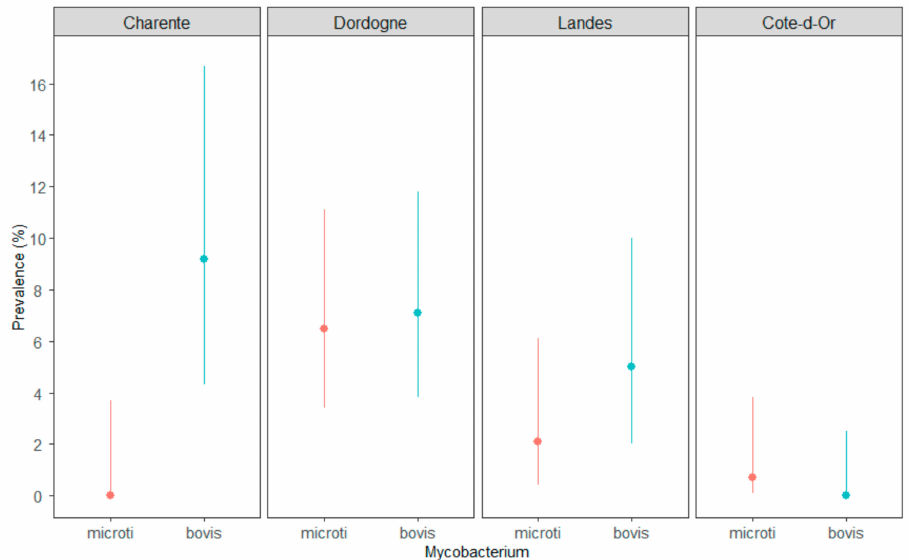
Figure 1. Comparison of M. microti (in red) and M. bovis (in blue) prevalence in three TB areas of Nouvelle-Aquitaine—Charente, Dordogne (season #1) and Landes—and in the core TB infected area of C ô te-d’Or, France. The lines are the CI 95% of the